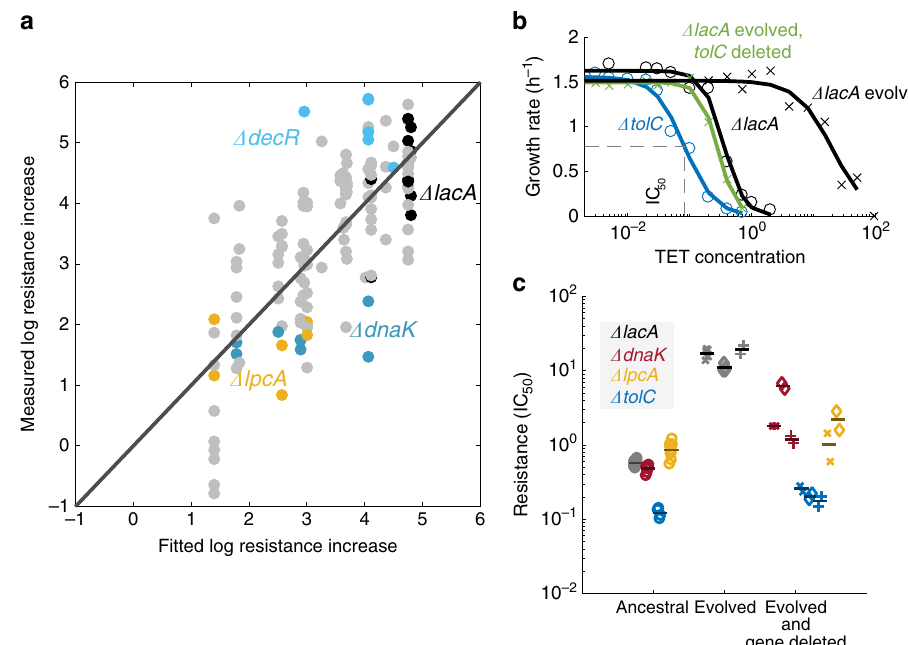
Fig. 6 Epistasis between gene deletions and resistance mutations underlies altered evolutionary dynamics. a Measured vs. predicted log resistance increase for each sequenced evolved population. For the prediction, the fi ve most common mutations were considered (Methods). The black circles represent control ( Δ lacA ) strains. Δ decR , Δ lpcA , and Δ dnaK samples are highlighted to visualize that their effects systematically deviate from predictions. b Dose – response curves for four strains. Black circles represent the ancestral Δ lacA , blue circles represent the ancestral Δ tolC , black crosses represent a clone isolated from an evolved Δ lacA population and green crosses represent the same clone with tolC deleted. A Hill function is fi tted to each set of measurements. The value of the IC 50 — the concentration at which the growth rate is half of the maximum — is shown with dashed gray lines for Δ tolC . c Resistance level (IC 50 ) of the ancestral strains (circles): Δ lacA (reference, gray, n = 32), Δ dnaK (red, n = 8) , Δ tolC (blue, n = 4), and Δ lpcA (yellow, n = 9); three different resistant (evolved from Δ lacA ) clones (crosses, n = 6, diamonds, n = 6, plus signs, n = 2), and strains where dnaK , tolC , and lpcA are deleted on the background of the respective resistant clones ( n = 2, Methods). Each symbol shows an IC 50 determined from an independent measurement of the dose – response curve (as shown in panel b for Δ tolC ); for all ancestral strains, the IC 50 was determined independently from the beginning of experiments M2 and M3 as in Fig. 2b (Methods). Black horizontal lines represent the mean resistance value of each strain. The deletions of each gene ( dnaK, tolC, and lpcA ) on the resistant background signi fi cantly decrease resistance (left to right: p = 7×10 − 7 , p = 5×10 − 4 , p = 4×10 − 3 , p = 3×10 − 8 , p = 7×10 − 9 , p = 2×10 − 3 , p = 2×10 − 5 , p = 4×10 − 5 , two-sided t -test on log values, Methods). The resistance decrease due to these deletions on the resistant background is greater than on the sensitive background, exposing epistasis between resistance mutations and these gene deletions (left to right: p = 7×10 − 9 , p = 2×10 − 3 , p = 3×10 − 9 , p = 3×10 − 5 , p = 4×10 − 5 , p = 3×10 − 5 , p = 3×10 − 7 , p = 5×10 − 6 , two-sided t -test on normalized values, Methods). Deleting tolC in the evolved strains lowers their resistance to slightly below the initial resistance level of the reference strain. The evolved strains used are lacA-M3-1 – 3 (crosses), lacA-M3-2 – 2 (diamonds), and lacA-M3-2 – 3 (plus signs); see Supplementary Data 1 for detailed information on the mutations that occurred in the evolved